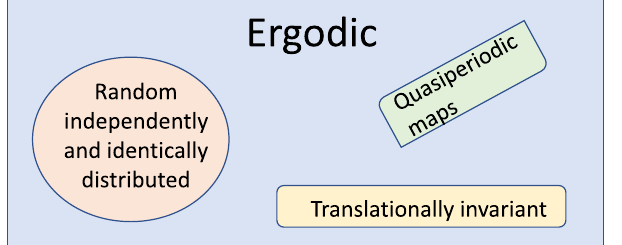
FIG. 1. Venn diagram for distributions of possible ergodic sequences of channels. Among the many subsets, three subsets are shown and substantially enlarged for